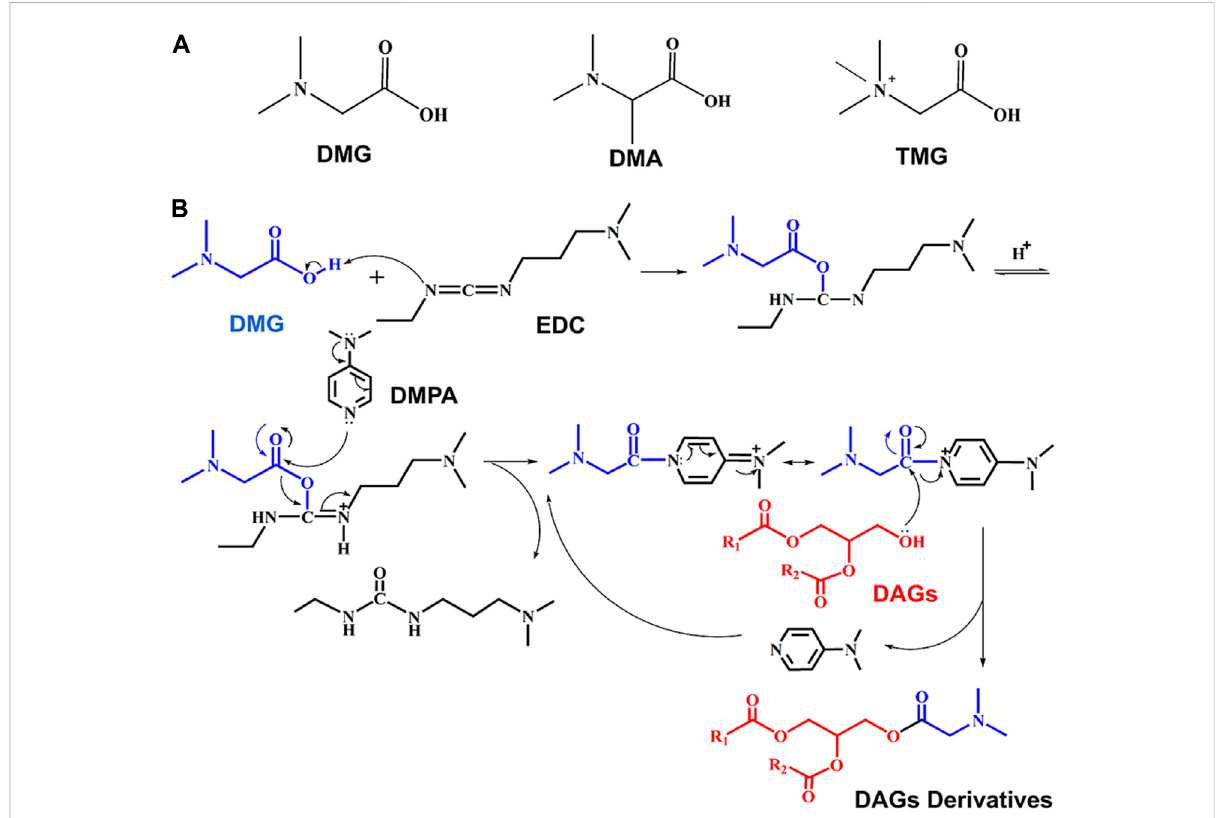
FIGURE 1 Derivatization reaction fl ow of DAGs. (A) Structure of charge derivatization reagents; (B) the process of charge